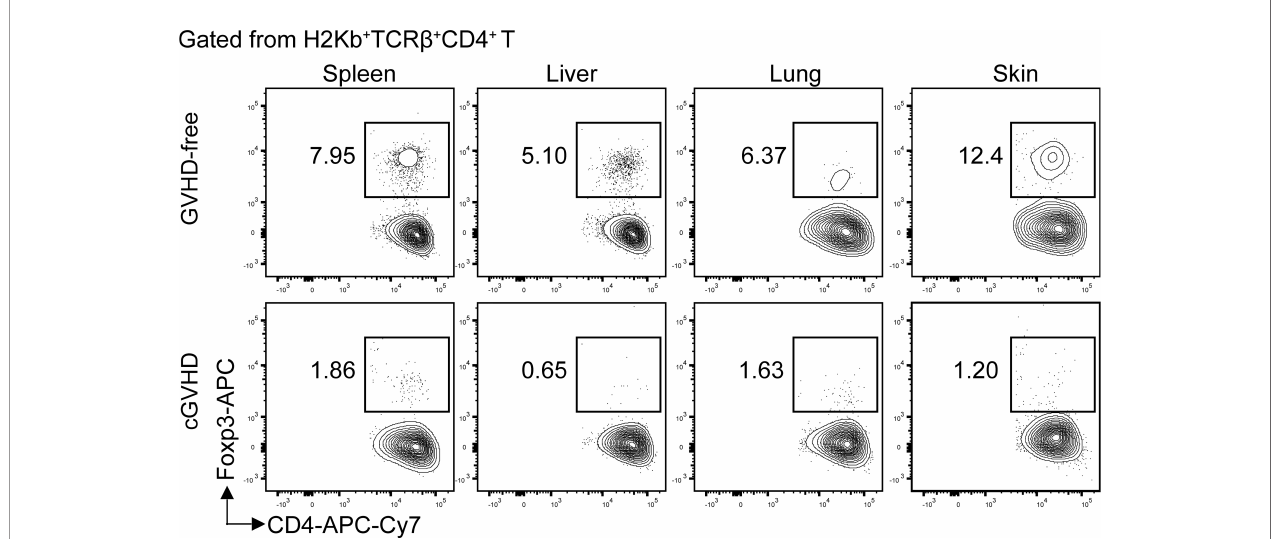
FIGURE 1 | Loss of Foxp3 + CD4 + Treg cells in the target tissues of chronic GVHD recipients. Lethal TBI-conditioned BALB/c recipients were given T-cell – depleted bone marrow cells (TCD-BM, 2.5 × 10 6 ) only from C57BL/6 donors as GVHD-free control or given TCD-BM plus spleen cells (1 × 10 6 ) for induction of chronic GVHD. Sixty days after HCT, the spleen, liver, lung, and skin tissue mononuclear cells were stained with anti-H-2K b , TCRb, CD4, and FoxP3. The gated donor-type H-2K b+ CD4 + TCR b + T cells are shown in CD4 versus Foxp3. The FoxP3 + Treg cells are boxed, and the percentage of the Treg cells among the CD4 + T cells is shown beside the box. One representative is shown of four recipients in each